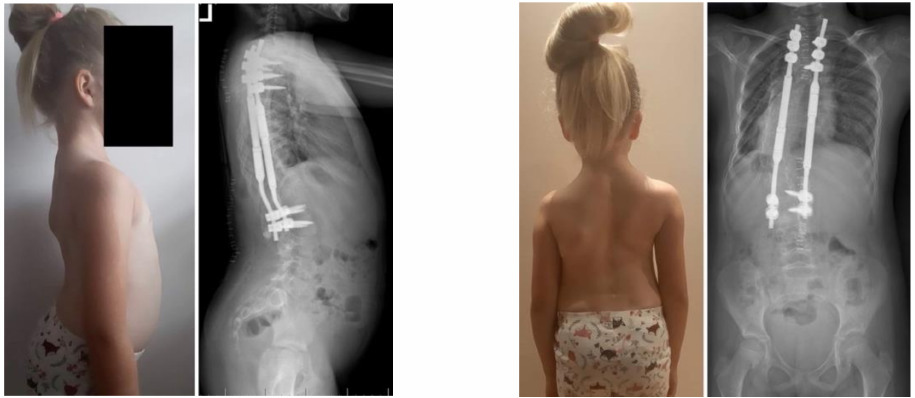
Figure 8. X-rays at 5-year follow-up, after revision surgery for MCGR replacement. Intraoperatively, metallosis was observed around the screw–rod junction. After re- vision surgery, the patient was discharged on the fifth day after surgery without a brace. There was no external rod fracture, but there were many wear marks at the junction between the extended portion of the rod and actuator (Figure